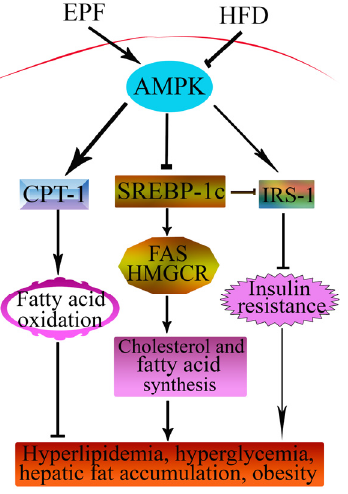
Figure 7 . Schematic diagram showing protective signaling of EPF in livers of HFD ‐ fed mice. The → indicates activation or induction, and ┤ indicates inhibition or blockade